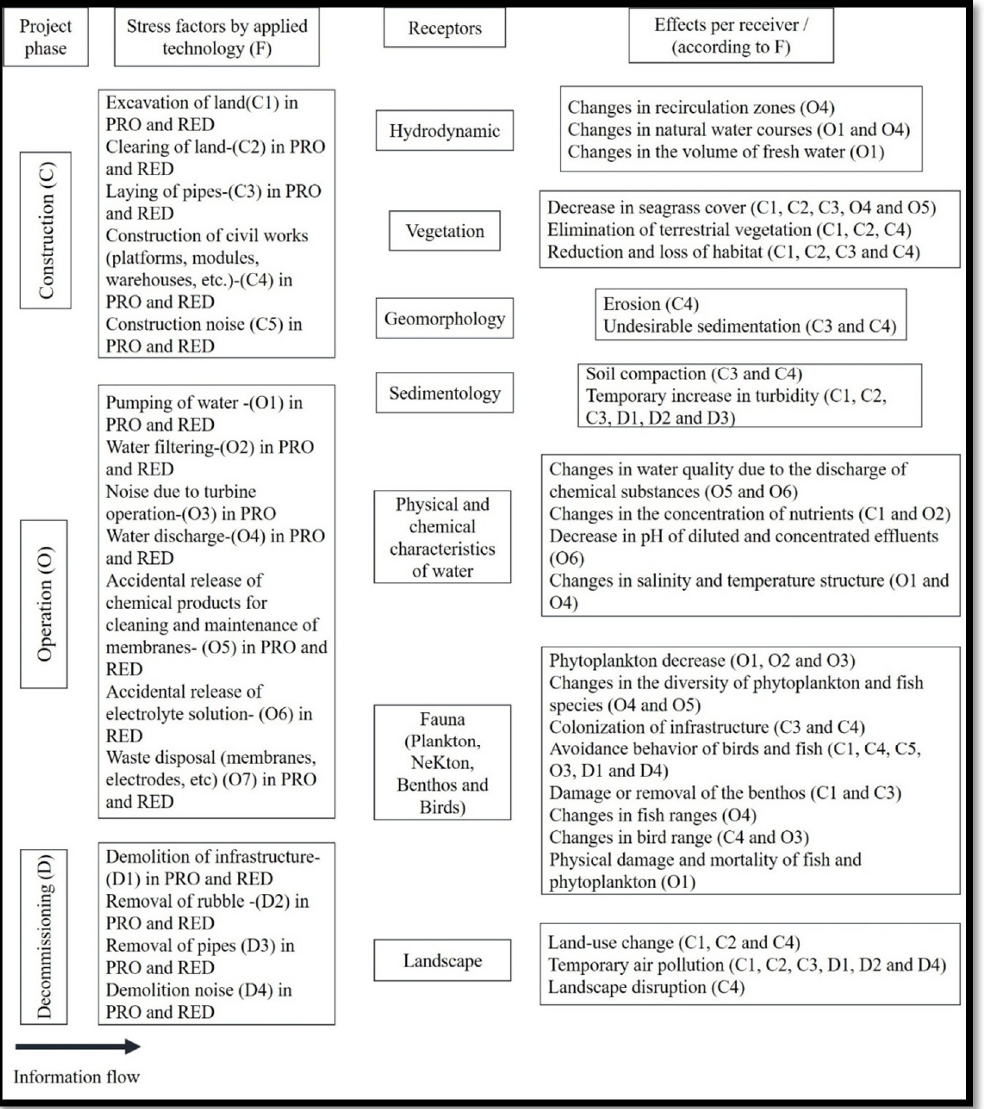
Figure 3. Stressors, receptors, and possible effects due to the implementation of SGE in La Carbonera lagoon in a three-stage scheme (construction, operation, and decommissioning) for the main components of the PRO and RED technologies. The letters indicate the number of stressors according to the phase of the project.